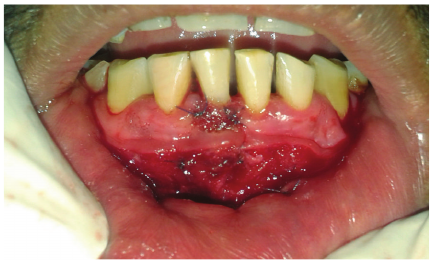
Figure 7: Suturing done using 5-0 resorbable sutures.